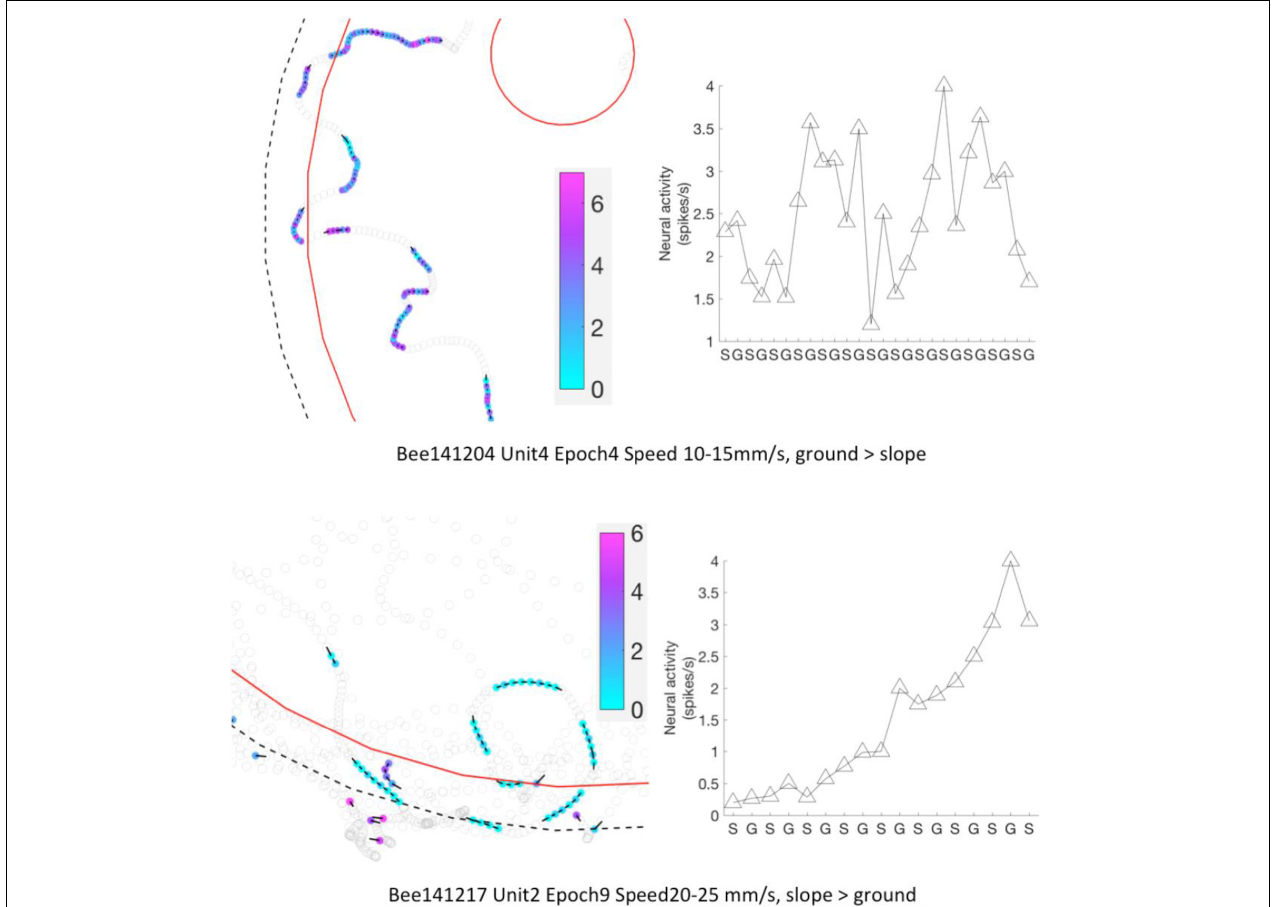
FIGURE 11 | Neural activity of MBENs accumulated for each significant epoch of walking between slope and ground. Each row shows one significant epochs from two bees. Left panels: examples for parts of the arena that included frequent region shifts of the bee between slope and ground. Bee locations in a significant epoch are highlighted with color dots; neural activity (spikes/s) from low to high is represented from light blue to magenta (color bar). Other bee locations are marked with open circles. Black bars point to heading direction at that tracking point. Right panels: mean spike numbers on slope and ground during region shifts in the same sig. epoch as left panels . S: slope; G: